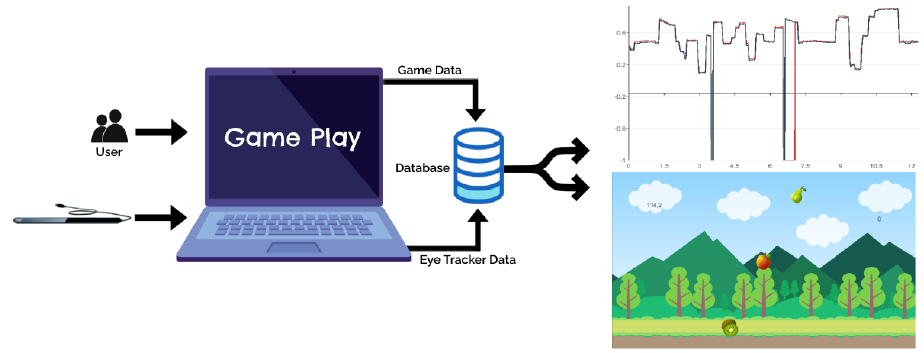
Figure 2. System design of vision training games.